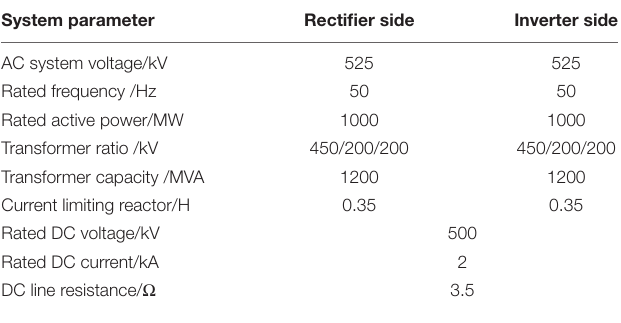
TABLE 1 | Main parameters of HMIDC